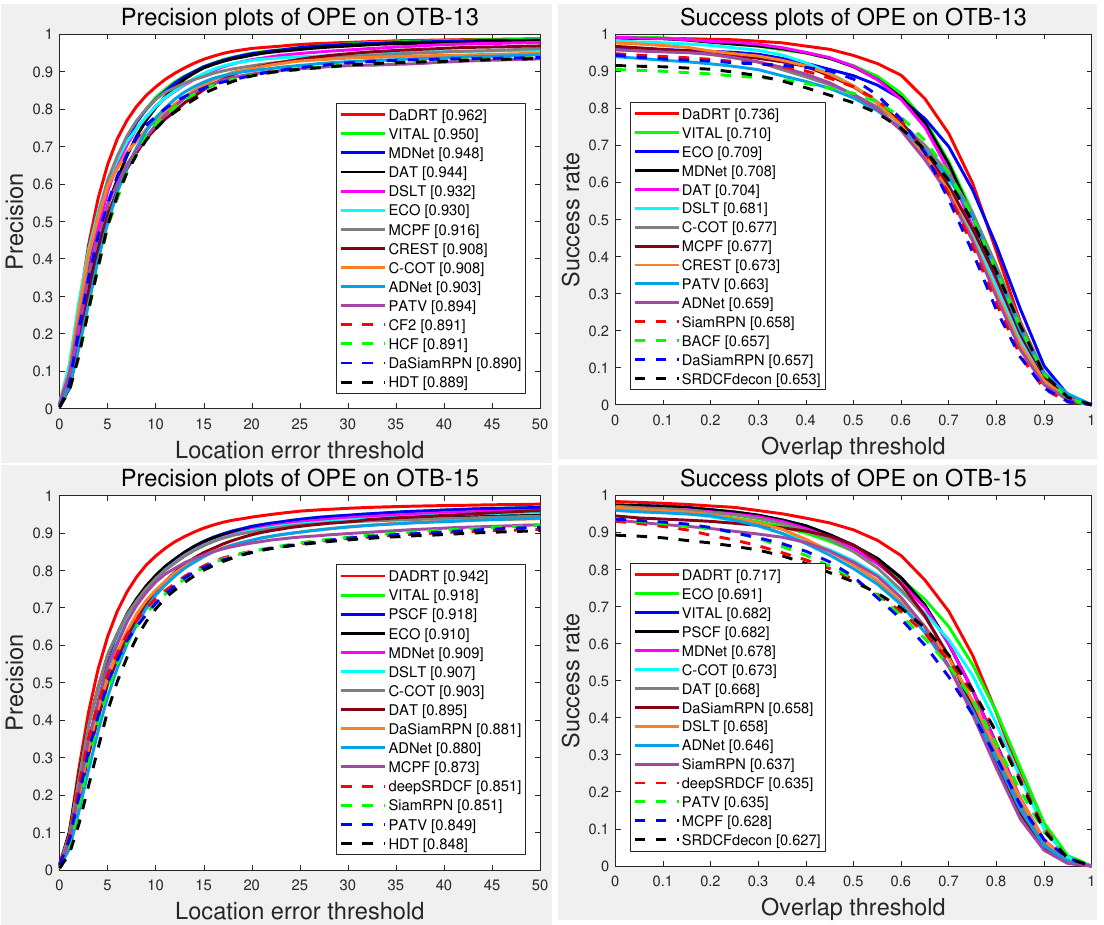
Figure 5. Precision and success plots using one-pass evaluation on the OTB-13 and OTB-15 datasets. The performance score for each tracker is shown in the legend. Our tracker achieves leading performance among the evaluated trackers. Results are best viewed on high-resolution